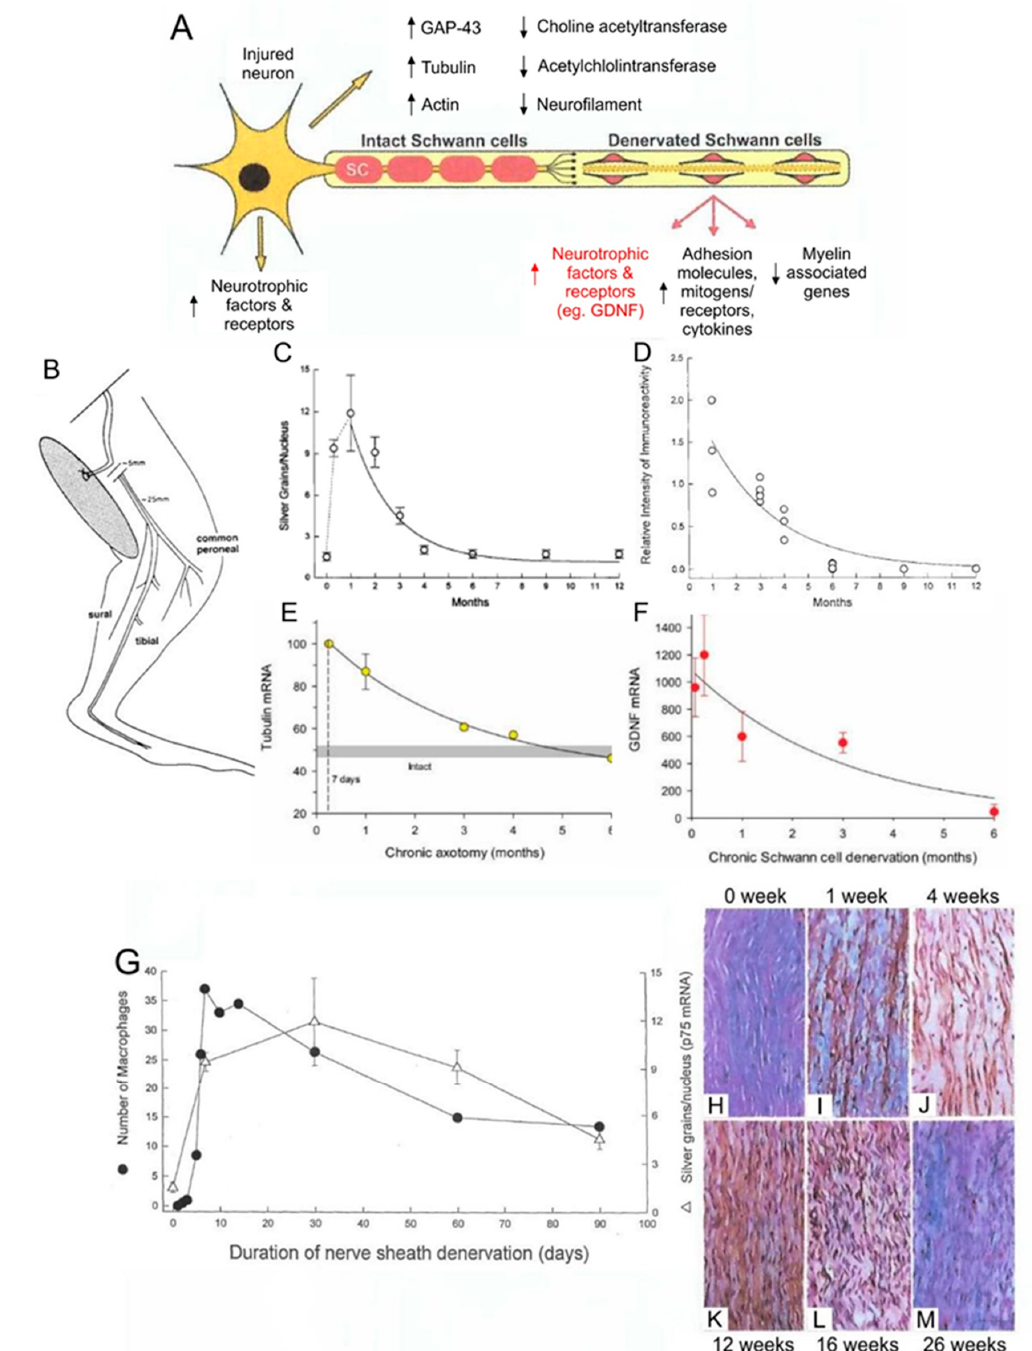
Figure 1. Expression of growth-associated genes in axotomized motoneurons after loss of target connections and in chronically denervated Schwann cells (SCs) in the distal nerve stumps. An illustrated motoneuron showing expression of growth-associated genes in motoneurons and in Schwann cells in the distal nerve stumps after a nerve injury ( A ). Experiments were performed in which we cut the sciatic nerve and sutured both proximal and distal nerve stumps to innervated muscle to prevent regeneration ( B ). p75NTFR in situ hybridization showing an early rise in expression in the denervated SCs in the distal nerve stump that declined within 6 months ( C ). Immunocytochemical evidence of a concomitant decline in p75 protein in the chronically denervated Schwann cells. ( D ). In situ hybridization showing a progressive decline to baseline values in the upregulation of the mRNA of the cytoskeletal protein tubulin in axotomized motoneurons ( E ). Semi-